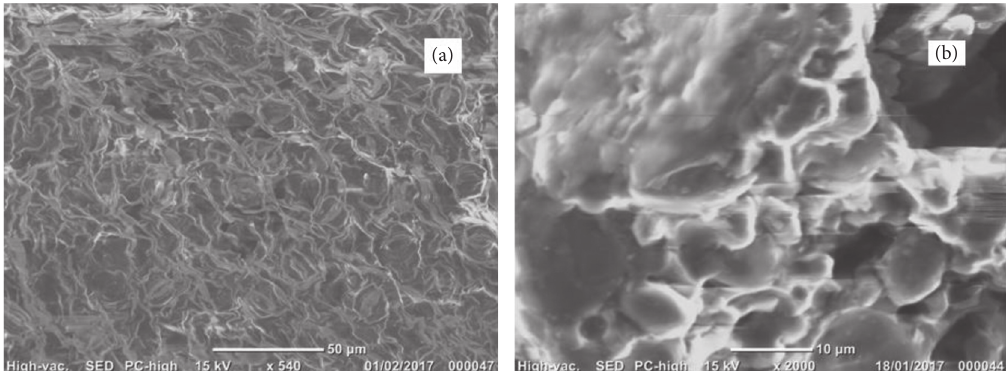
Figure 1: Preprocessing of adsorbent and adsorption process.